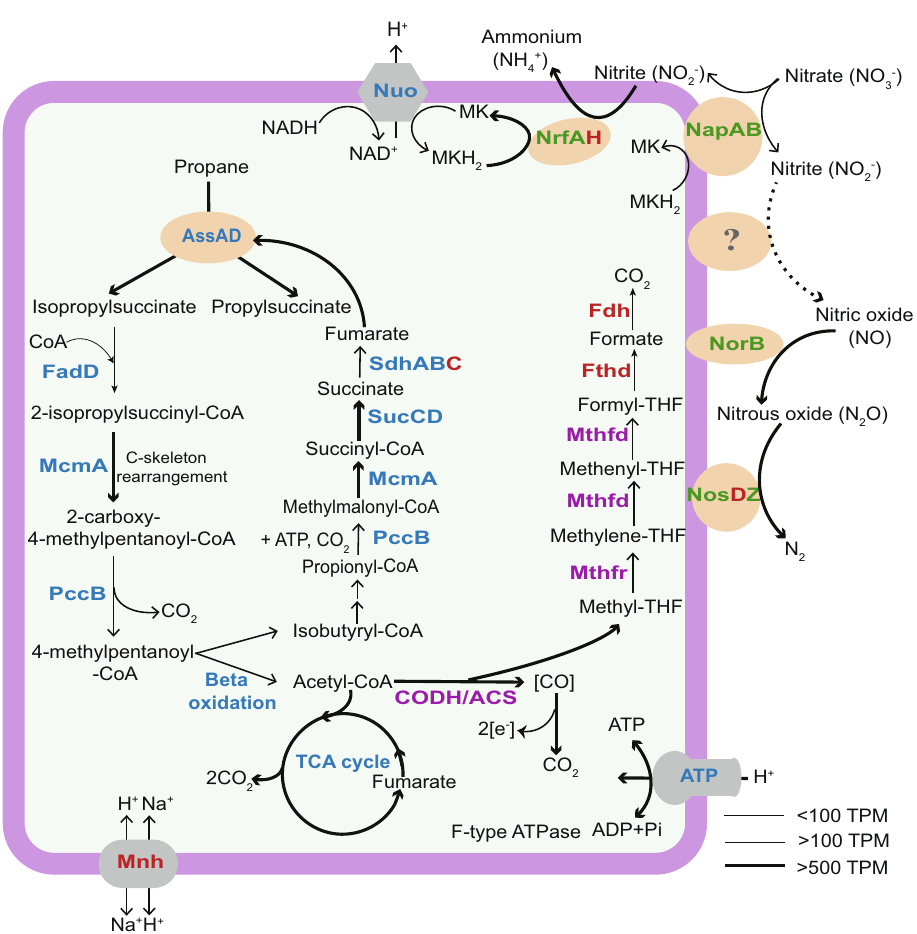
Fig. 5 | Proposedmetabolic pathway for anaerobicpropane oxidationcoupled to nitrate reduction. The ‘ Ca . A. nitratireducens ’ enrichment culture utilized an alkylsuccinate synthase to activate propane to n- and iso -propylsuccinate. Acetyl- CoA is produced after carbon-skeleton rearrangement, decarboxylation and beta- oxidation. Acetyl-CoA oxidation to CO 2 is catalysed by enzymes involved in the oxidative tricarboxylic acid cycle or reverse Wood – Ljungdahl pathway (purple labels). ‘ Ca .A.nitratireducens ’ harbouredalltheenzymesinvolvedindenitri fi cation (NapAB, NorB, NosZ, except NirS/K) and DNRA processes (NapAB, NrfAH) (green text). Normalized gene expression for ‘ Ca . A. nitratireducens ’ is indicated as TPM (total transcripts per million). Increasing line thickness shows increasing gene expression values. Enzymes labelled in blue, green, purple and boldtext